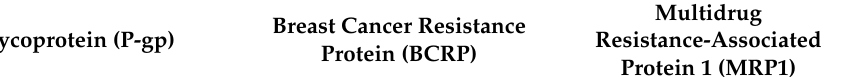
Table A7. Antipsychotics—substrates of transport proteins.